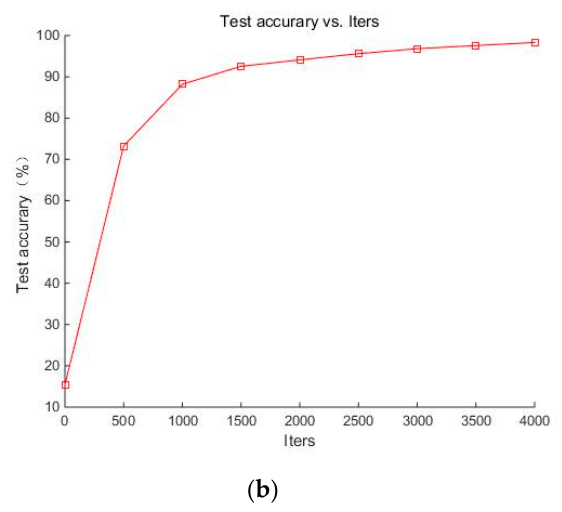
Figure 8. Relationship between loss function, accuracy, iteration number: ( a ) Relationship between loss function and iteration; ( b ) accuracy graph.